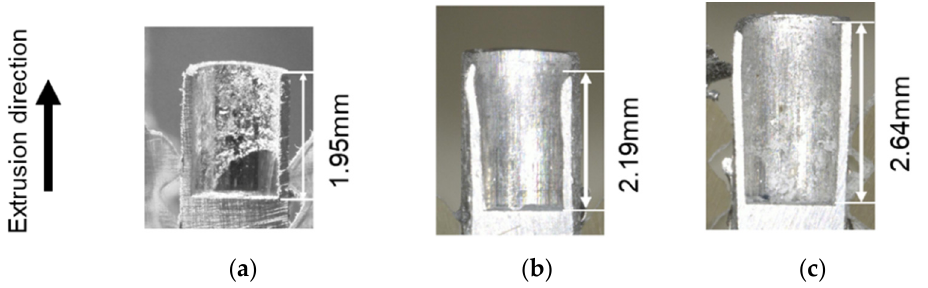
Figure 5. Longitudinal section cross-sectional images of the extrusion: ( a ) mirror surface punch; ( b ) grooved punch (depth 10 µm); and ( c ) grooved punch (depth 5 µm)